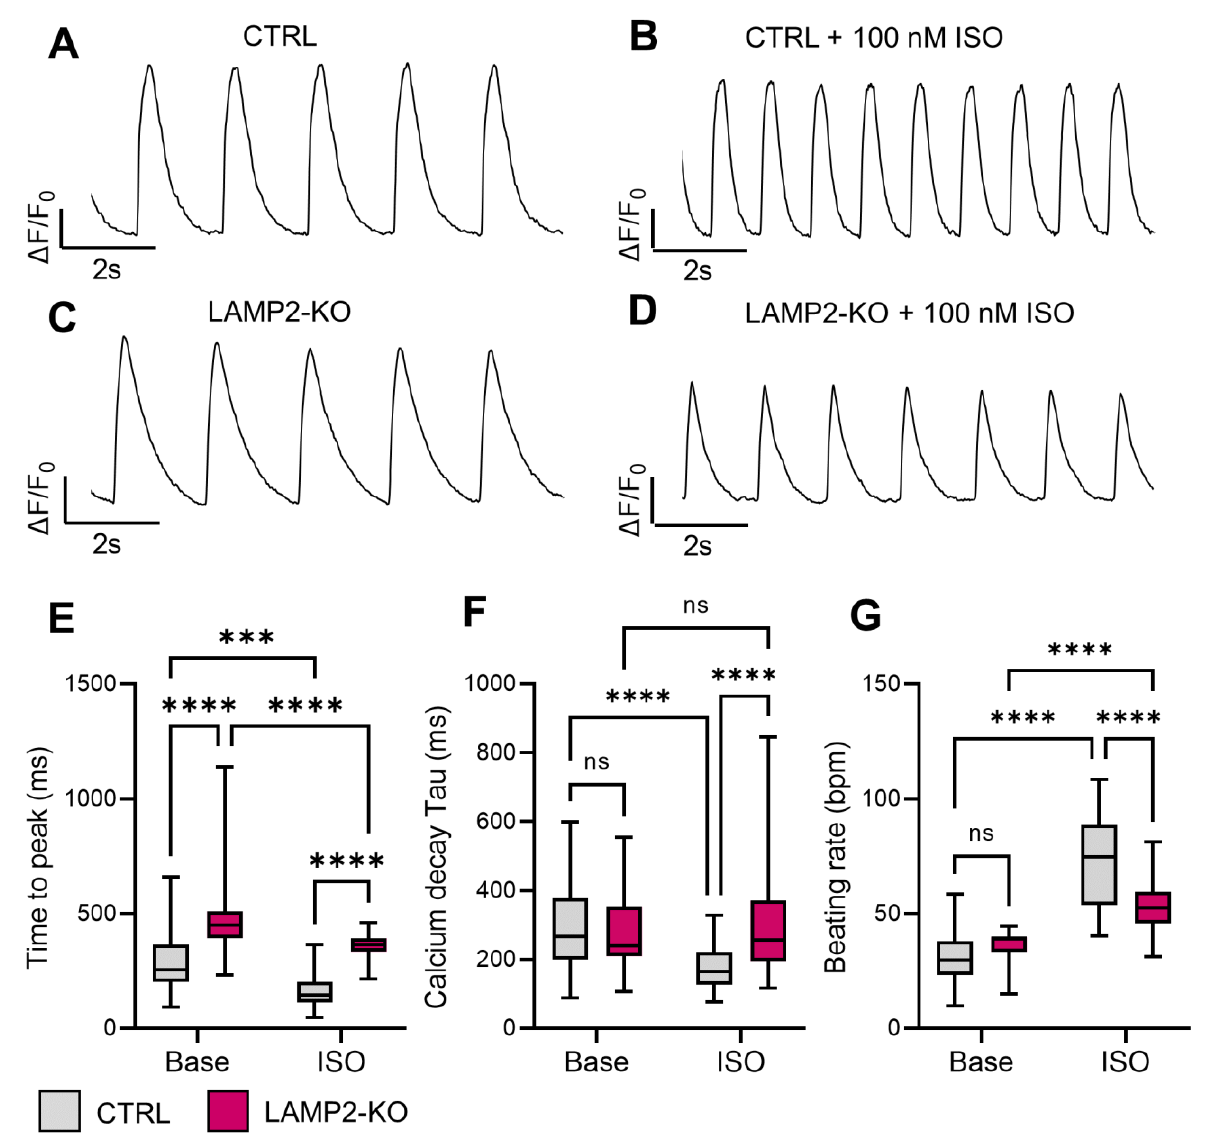
Figure 3. LAMP2 KO impairs β -adrenergic signaling in iPSC-CMs. ( A , B ) Representative Fluo-4 calcium transient trace in Ctrl iPSC-CMs before ( A ) and after ( B ) isoproterenol (ISO) treatment; ( C , D ) Representative Fluo-4 calcium transient trace in LAMP2 KO iPSC-CMs before ( C ) and after ( D ) ISO treatment; ( E – G ) LAMP2 KO iPSC-CMs exhibit prolonged transient rise ti € ( E ) and unchanged transient decay Tau ( F ) and beating rate ( G ) at baseline compared to Ctrl group. ISO treatment induced smaller functional improvement in LAMP2 KO groups compared to Ctrl, resulting in significant differences between Ctrl and LAMP2 KO cells. N = 59, 103, 37, and 90 cells in Ctrl, LAMP2 KO, Ctrl + ISO, and LAMP2 KO + ISO group from at least 3 independent experiments. ns: no significance, *** p < 0.001 and **** p < 0.0001 by two-way ANOVA test followed by Holm – Sidak method.